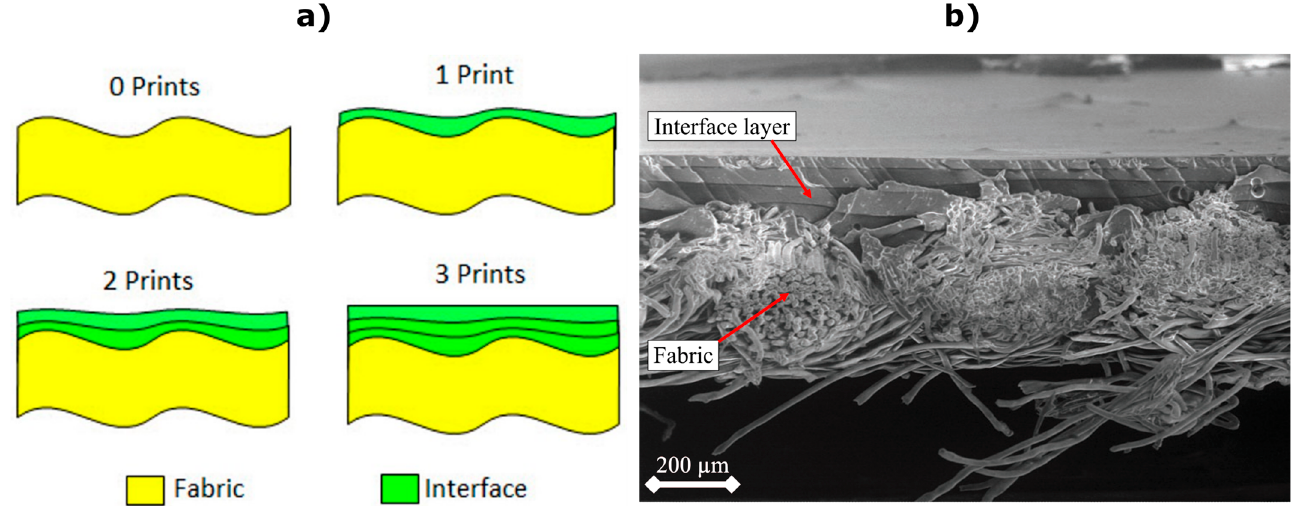
Figure 1. ( a ) The application of the primer layer to reduce the surface roughness of the fabric and improve homogeneity. ( b ) A cross-sectional micrograph obtained using scanning electron microscopy showing 4 primer layers printed on polyester cotton. The image shows the cross-section of 3 yarns, with other fibres running perpendicular. The boundaries between the 4 individually printed and cured primer layers can be seen filling the gaps in the fabric between the yarns and subsequently presenting a smoother top layer.